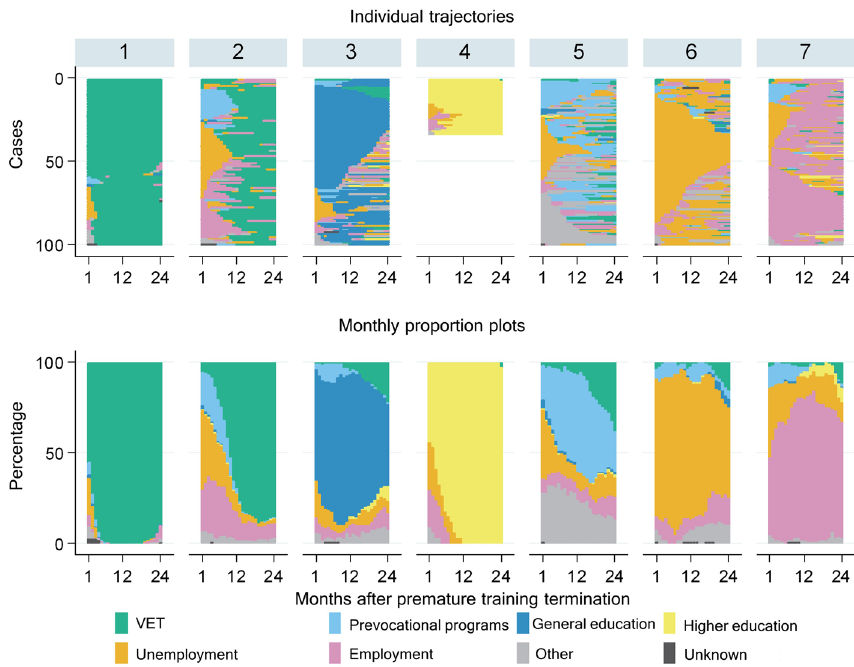
Fig. 2 Subsequent trajectory clusters within 24 months after PTT. Note. Names of clusters: 1 Direct re-entry into VET, 2 Later re-entry into VET, 3 Further school attendance, 4 Transition to higher education, 5 Fragmented trajectories, 6 Transition to unemployment, 7 Transition to employment; Reading note: The above plots are individual trajectories of 100 persons per cluster and have to be read horizontally. As an example, in cluster 1 the majority of adolescents re-entered VET in the first month after PTT. The monthly proportion plots on the contrary have to be read vertically. Here, the distribution of the status of all cluster members for each month is shown ignoring the character of the individual sequence. For cluster 1 the monthly proportion plot shows that more than half of the cluster members were in VET in the first month after PTT. In month 12 all cluster members participated in